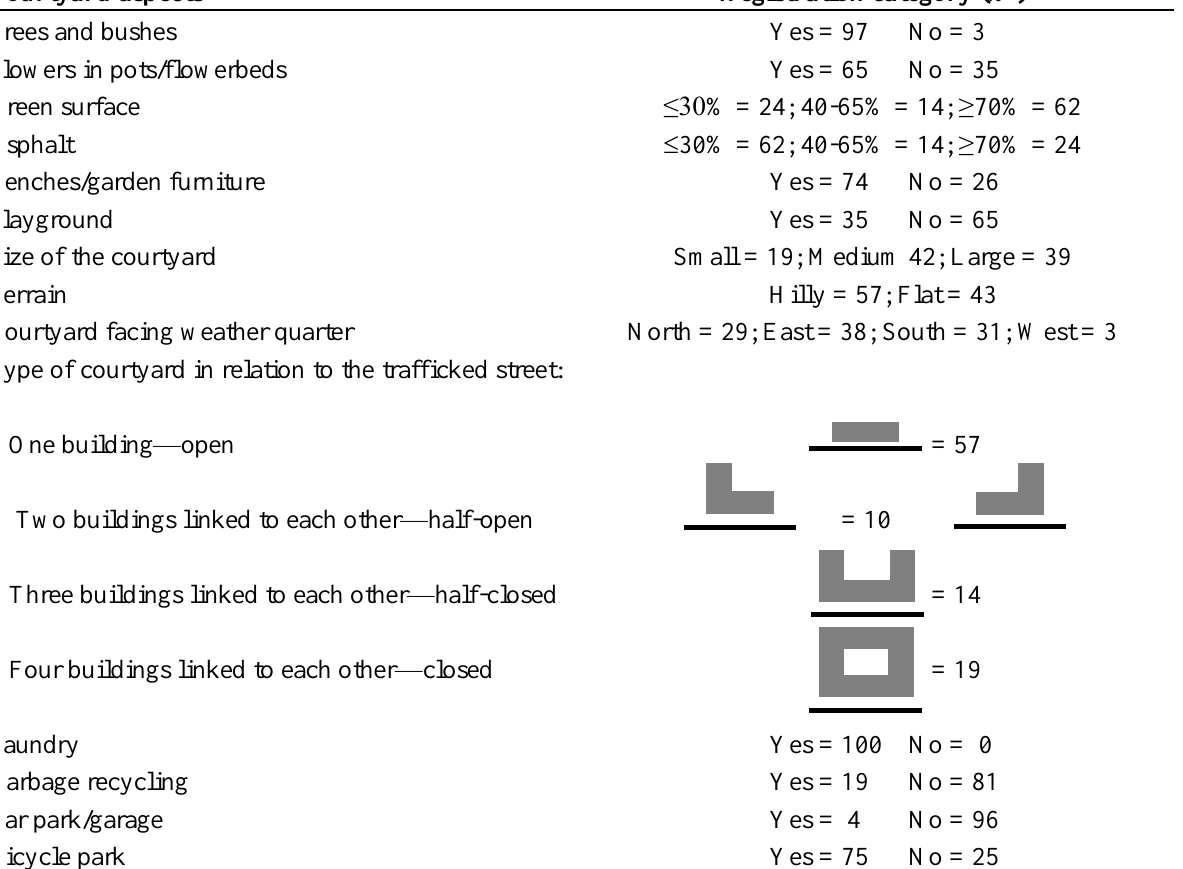
* The black lines represent the trafficked streets and the grey blocks represent the